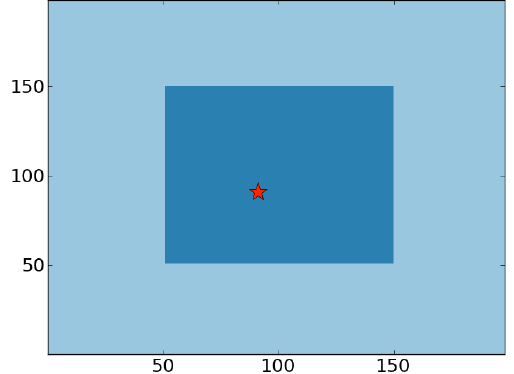
Figure 2. Prior flux uncertainty (kgCm − 2 year − 1 ). The un- certainty values are 1kgCm − 2 year − 1 for the hinterland, 10kgCm − 2 year − 1 for the urban box and 100kgCm − 2 year − 1 for the idealized power plant. The 200km × 200km domain is centered at the location of Shanghai (31.2 ◦ N, 131.5 ◦